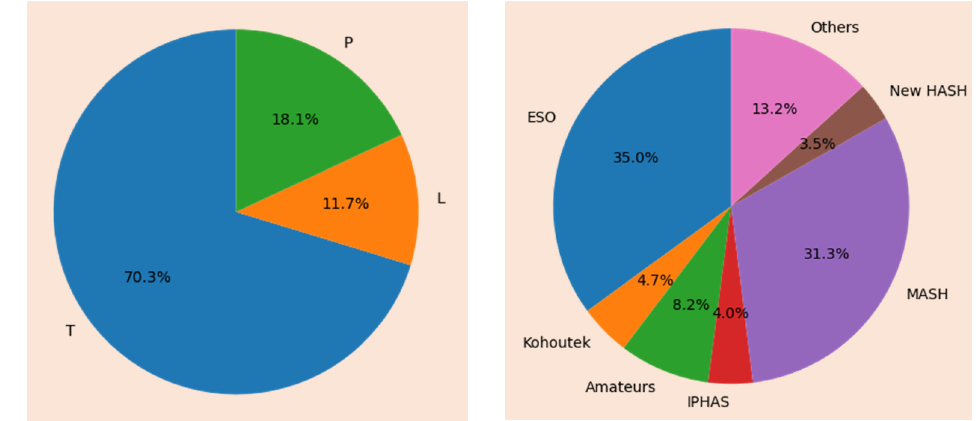
Figure 1. Pie charts that show the current base properties of Galactic Planetary Nebula recorded in the HASH database: ( Left panel ): Fraction of HASH PNe that are designated as True (T), Likely (L) or Possible (P) PNe following [4,5]; ( Right panel ): Breakdown of all currently known 3805 Galactic PNe (T 2668, L 446, P 691) by major catalogue origin.